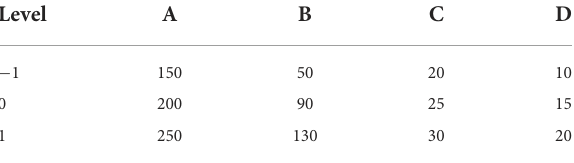
TABLE 1 Design of factors levels for